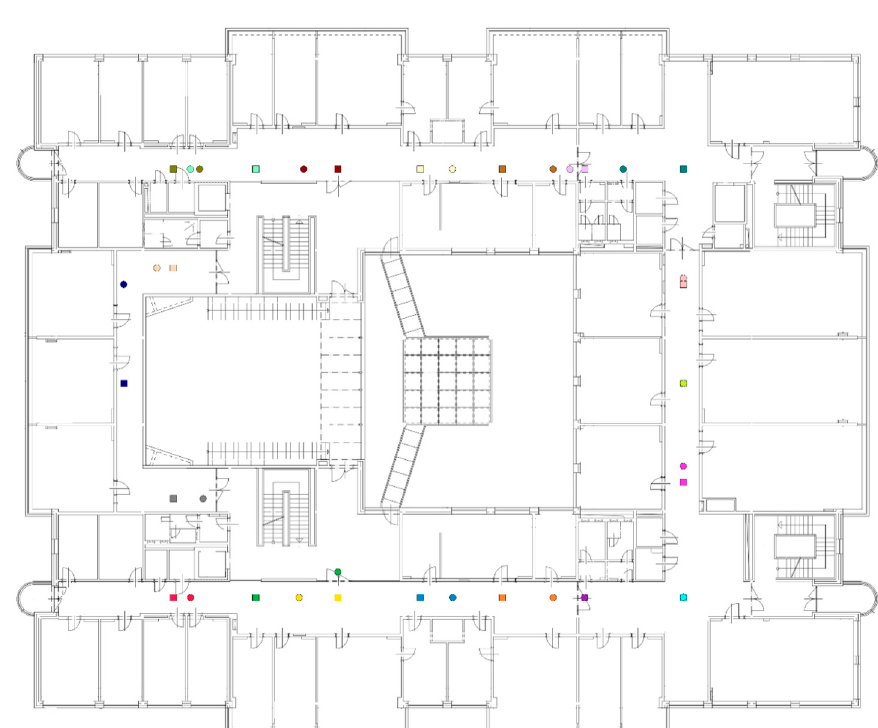
Figure 6. Visualization of test results for the Algorithm 3.